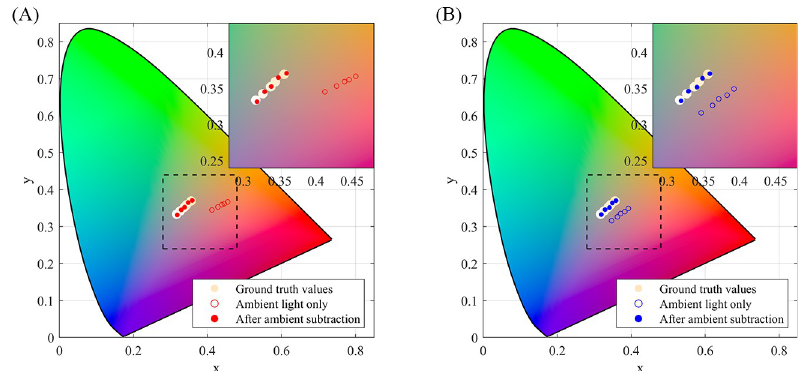
Fig 3. Visualising ambient subtraction in CIE 1931 chromaticity diagram for Jaundice Eye Colour Index (JECI) colours. JECI values are 0.01, 0.03, 0.05, 0.07, 0.09. After ambient subtraction, values come into alignment with ground truth values. (A) Under warm ambient illumination, correlated colour temperature is 2700K. (B) Under cool ambient illumination, correlated colour temperature is 6500K.